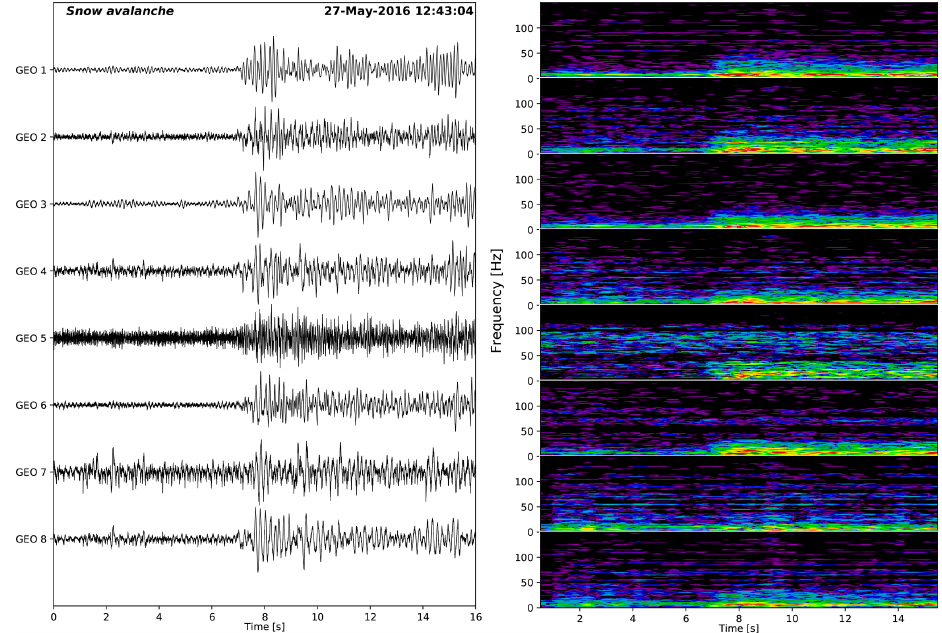
Figure B10. Vertical component traces of the event shown in Fig. 11. A first, weak arrival is visible around 2s before a second, stronger arrival at 8s. These observations are misleading and could be wrongly interpreted as P- and S-wave arrivals, respectively.